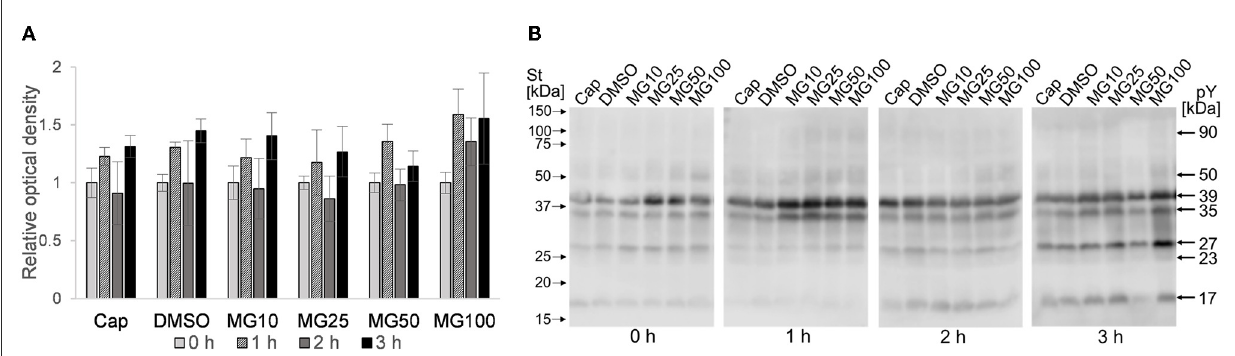
FIGURE5 Detection of total phosphotyrosine levels in sperm protein extracts during sperm in vitro capacitation under proteasomal inhibiting conditions at various concentrations of MG-132 (10, 25, 50, and 100 µ M) including capacitating (Cap) and vehicle (DMSO) controls. (A) Representative Western blot shows the molecular masses of pY. (B) The graph represents the total pY determined by densitometric analysis. Data are presented as mean ± SEM. No significant differences were observed; n = 5.